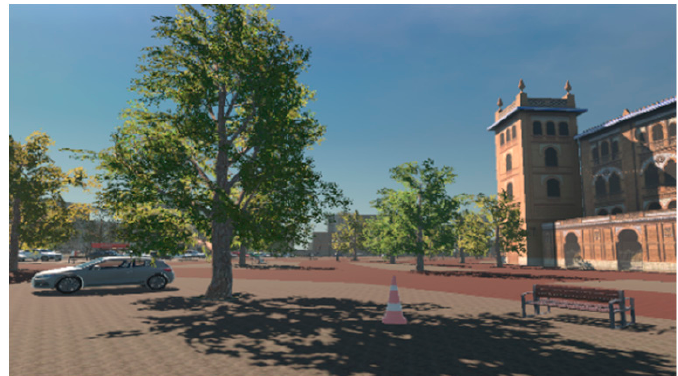
Figure 7. VR scenario for estimating distances of different objects: cones, benches, trees, and vehi- cles.